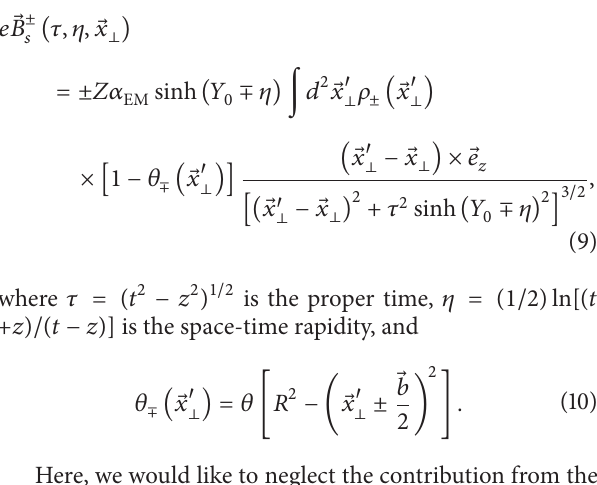
−3 , 𝑑 = 0.54 fm, and the radius 𝑅